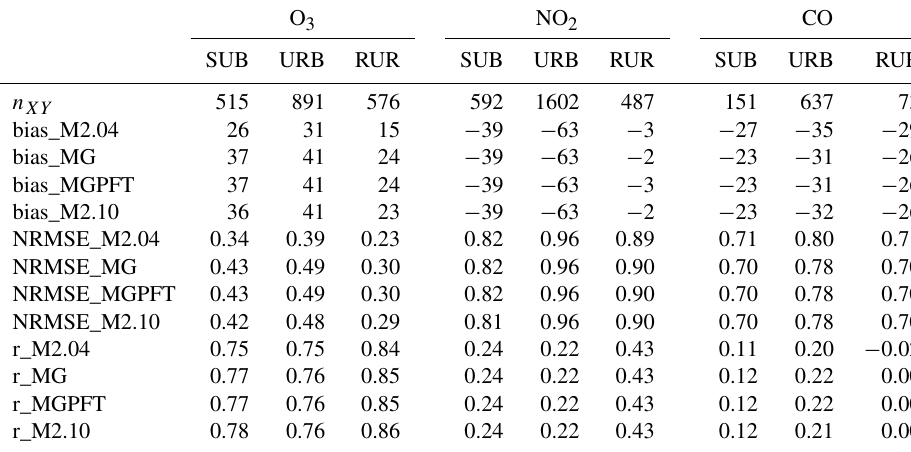
Table 5. Summary of the statistics between predicted and measured O 3 , NO 2 , and CO concentrations from the AirBase dataset (intended as the daytime hour weekly mean from 10 August 2015 at 00:00UTC to 16 August 2015 at 00:00UTC), namely the (a) normalized mean bias (bias – %), (b) normalized root mean square error (NRMSE – dimensionless), (c) the correlation coefficient ( r – dimensionless), and the relative number of points analyzed ( n XY ). Values are shown according to the different station areas of suburban (SUB), urban (URB), and rural (RUR), as well as the different WRF-Chem model runs (control simulation – M2.04, activity factors updated – MG, PFT emission factors updated – MGPFT, and the isoprene emission factors updated – M2.10).